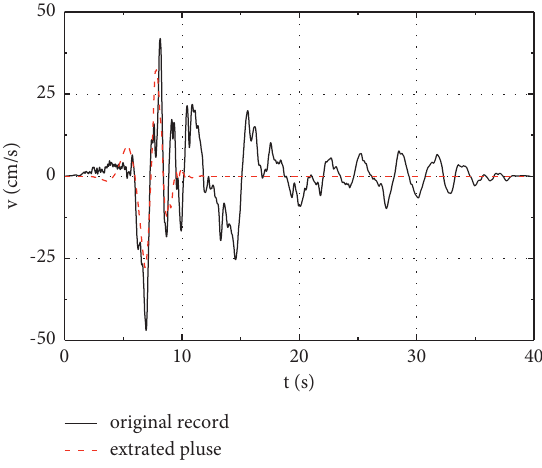
Figure 13: The most obvious velocity pulse. Table 2: Pulse-like ground motion